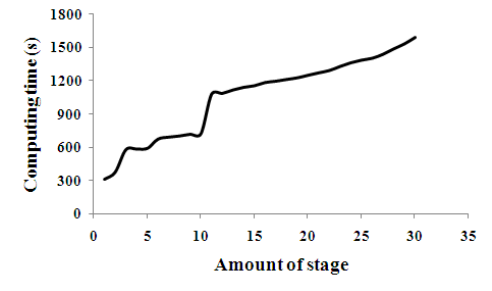
Fig. 7 The relationship between computation time and stage number